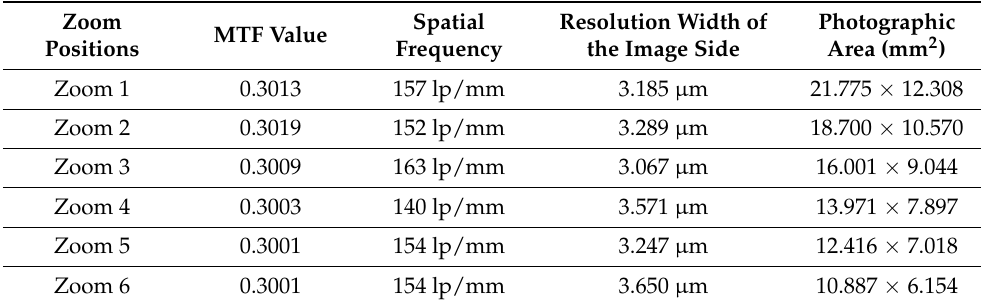
Table 6. Comparison of the lowest resolution for different zoom